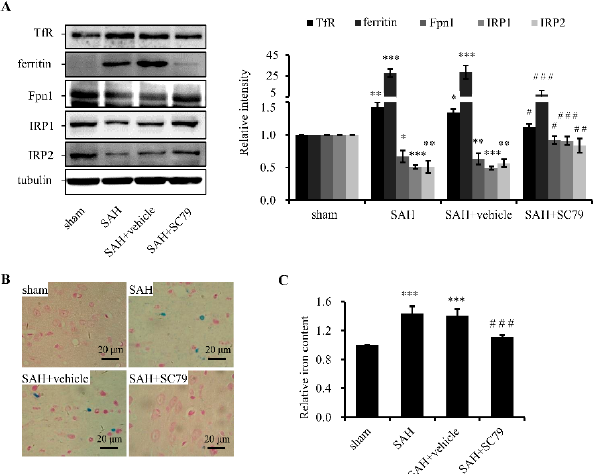
Figure 2. SC79 administration after SAH improves the disrupted iron homeostasis. ( A ) Western blotting for the protein levels of TfR, ferritin, Fpn1, IRP1, and IRP2 of the rat temporal cortex. Left panel: a representative protein levels of TfR, ferritin, Fpn1, IRP1, and IRP2. Right panel: quantitative data of the protein levels. Tubulin was detected as a loading control; ( B ) Prussian blue iron staining; and ( C ) iron content determined by ferrozine assays. Data are expressed as mean ± SD ( n = 8 in each group). * p < 0.05, ** p < 0.01, *** p < 0.001 vs. the sham group, # p < 0.05, ## p < 0.01, ### p < 0.001 vs. the SAH group. Definition of sham, SAH, SAH + vehicle, and SAH + SC79 groups is the same as in Figure 1. Fpn1, ferroportin 1; TfR, transferrin receptor, IRP1/2, iron regulatory protein 1/2.